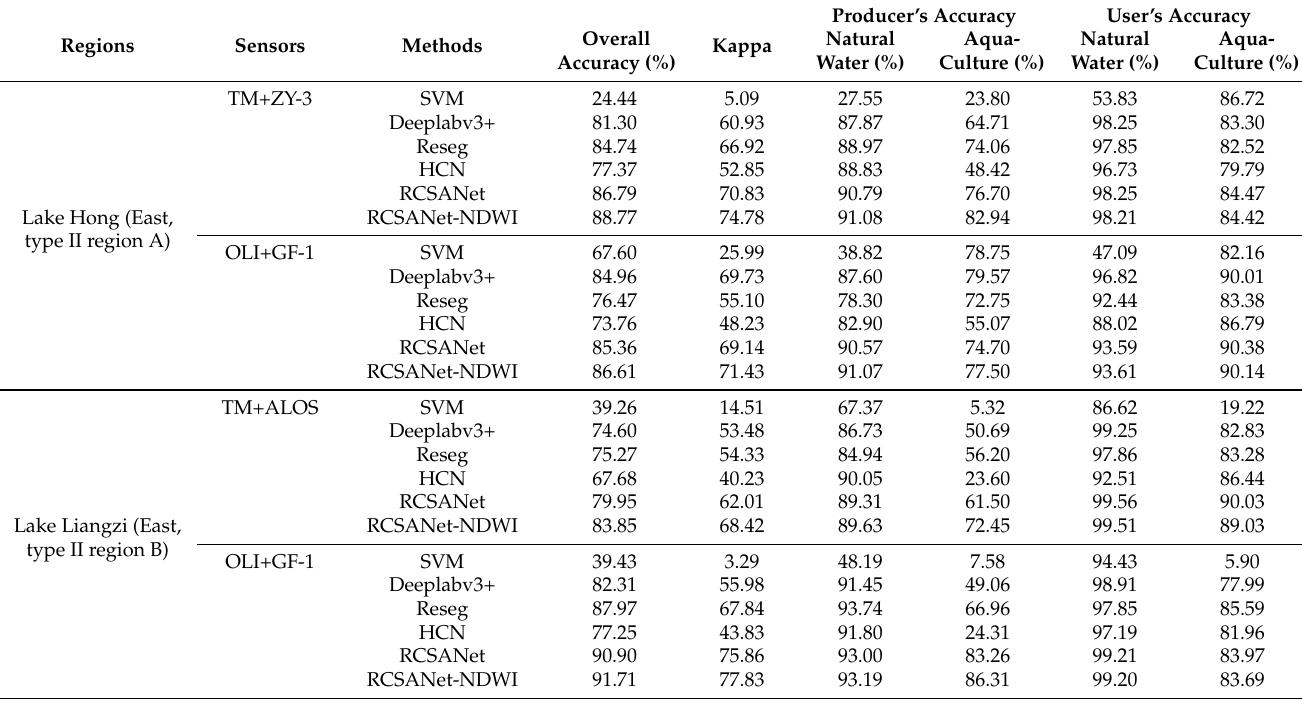
Table 4. Accuracy evaluation for the two classes, aquaculture ponds and natural water surfaces, in each experimental area